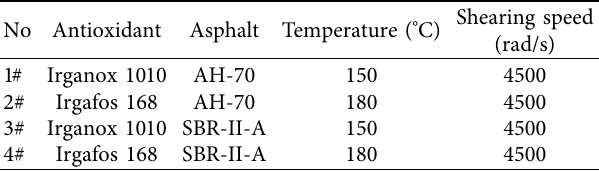
Table 3: Preparation conditions of modified asphalt.